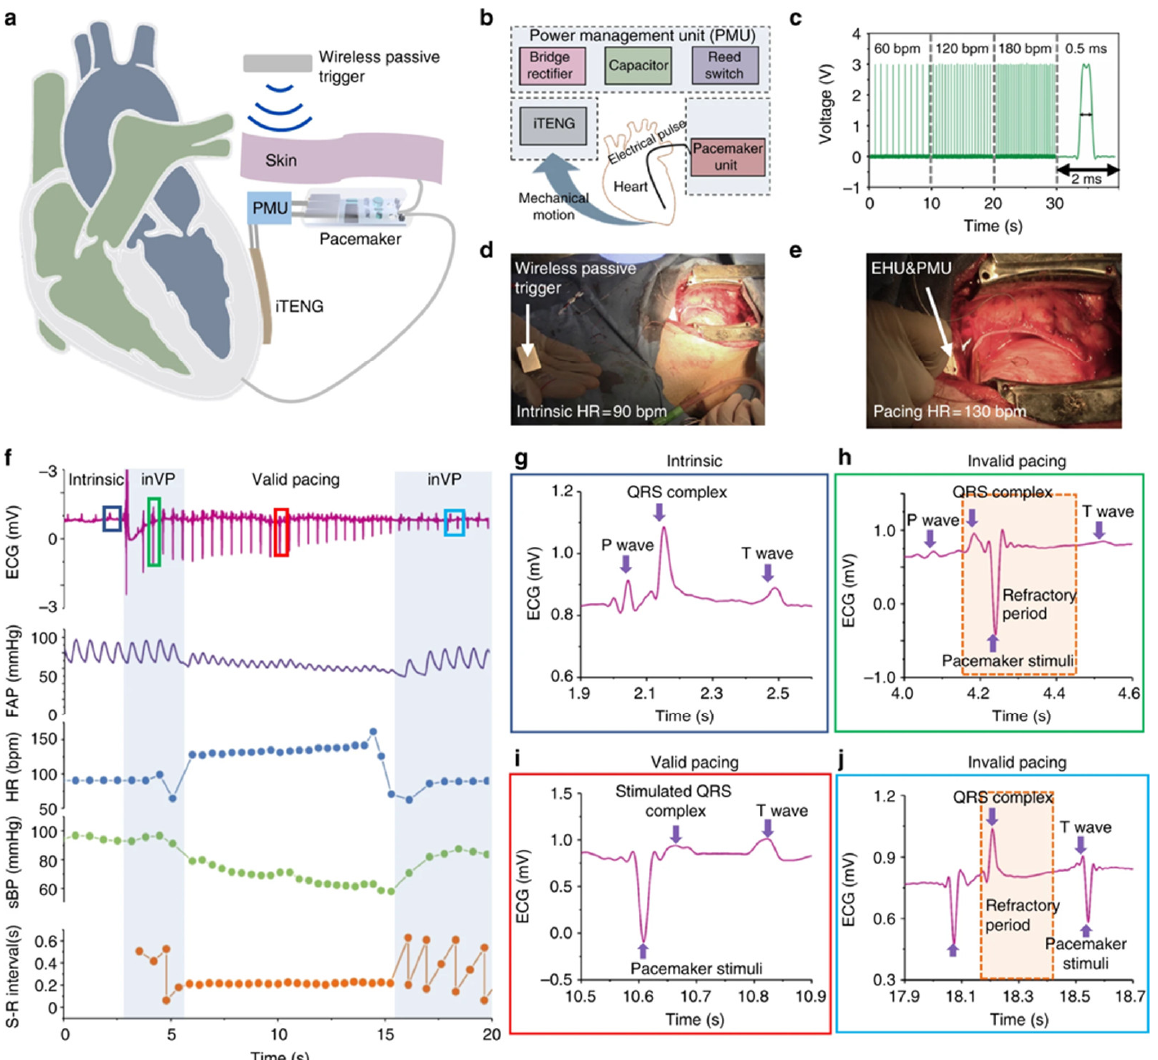
Figure 18. Performance of the symbiotic cardiac pacemaker designed by Ouyang et al. [110]. ( a ) Representation of the pacemaker powered by iTENG that harvests energy from the cardiac motion of a Yorkshire porcine. ( b ) Illustration of the main components of the symbiotic cardiac pacemaker system. ( c ) Stimulation voltage pulse under different frequencies produced by a pacemaker unit. ( d , e ) Photograph of the symbiotic cardiac pacemaker system switched on by wireless passive trigger in a pig. ( f ) Results of the stimulus-R wave intervals (S-R), systolic blood pressure (sBP), heart rate (HR), femoral artery pressure (FAP), and ECG during the stimulation stage of the symbiotic pacemaker unit. ( g ) ECG signal of the heart rate considering a normal systolic blood pressure. ( h ) ECG signal under a pacing stimulus in the refractory period, considering a normal systolic blood pressure. ( i ) ECG signal of the heart successfully placed by the symbiotic pacemaker unit, with decreased systolic blood pressure. ( j ) ECG signal under failed pacing stimuli, regarding a restored systolic blood pressure. Reprinted with permission from [110]. Copyright ©2019, Springer Nature.